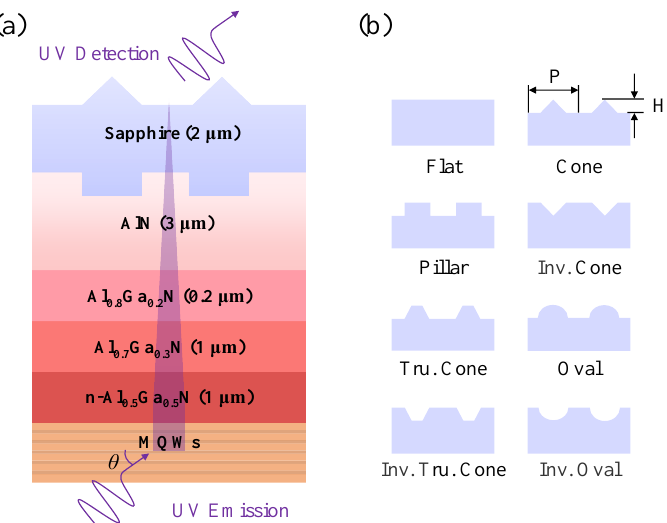
Figure 1. ( a ) Schematic diagram of the simulated structure of UV-LEDs. ( b ) The involved nanopat- terns for NPSSs and PCs.